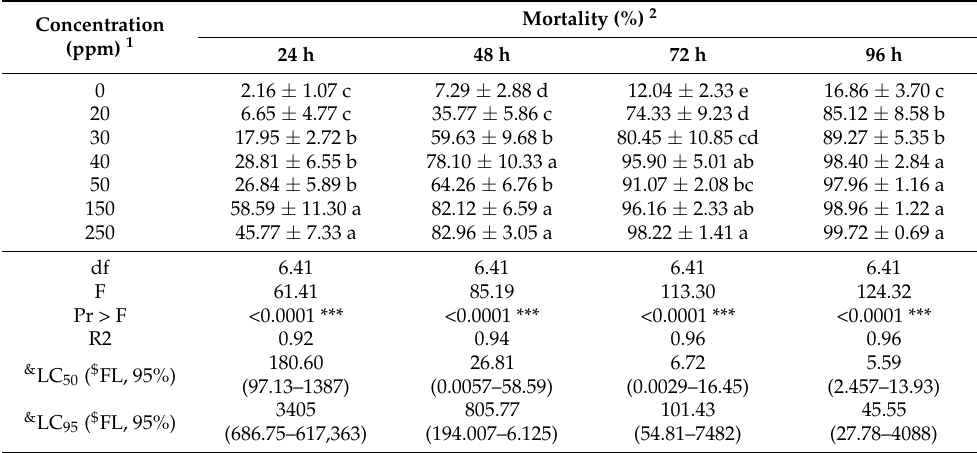
Table 4. Mortality ( ± SD) of tomato psyllid Bactericera cockerelli , with different concentrations of a combination of ZnO and TiO 2 NPs on tomato leaves in the laboratory.